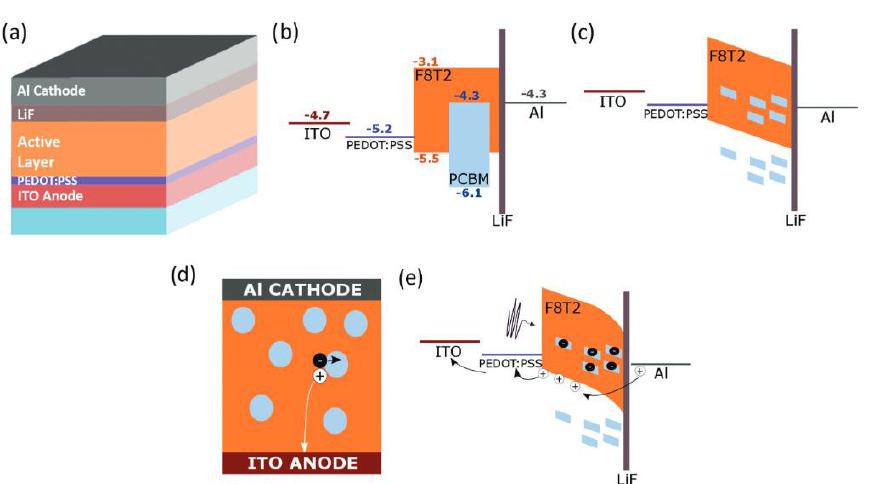
Figure 13. ( a ) Depiction of the device structure: The relative band energies of the layers in the dark ( b ) without and with ( c ) applied reverse bias; ( d ) The active layer morphology with isolated PC71BM clusters and the resulting charge trapping; ( e ) The band energies of the layers under illumination with a reverse bias applied and the resulting photomultiplication mechanism. (Reproduced with permission from [114]. WILEY Publishing, 2017).